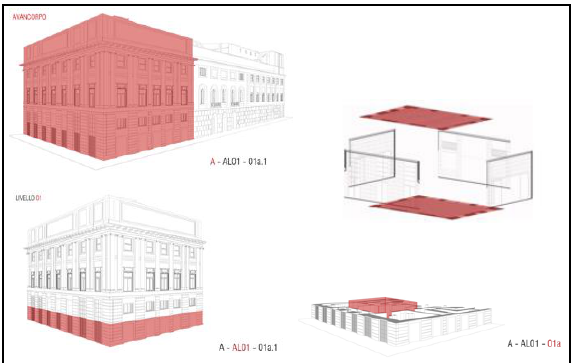
Figure 10. Classification of the forepart of the Lyric